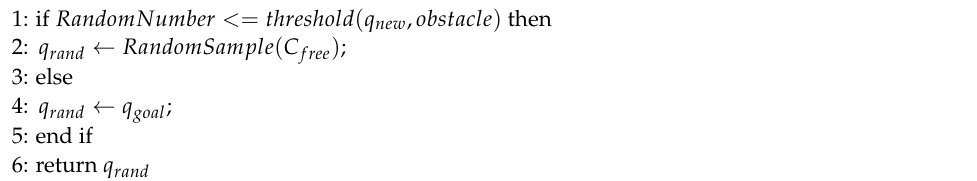
Algorithm 3. Probability Threshold under the Control of Potential